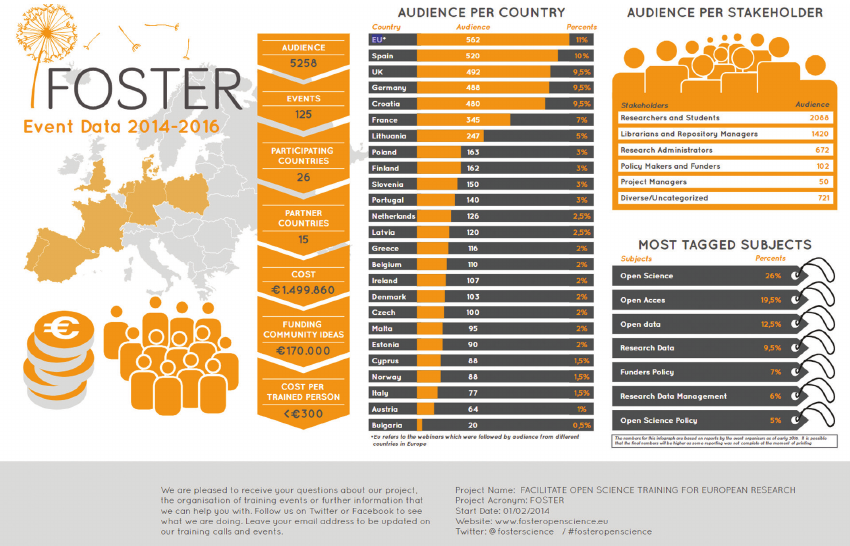
Fig. 1: FOSTER infographic (FOSTER Partners,